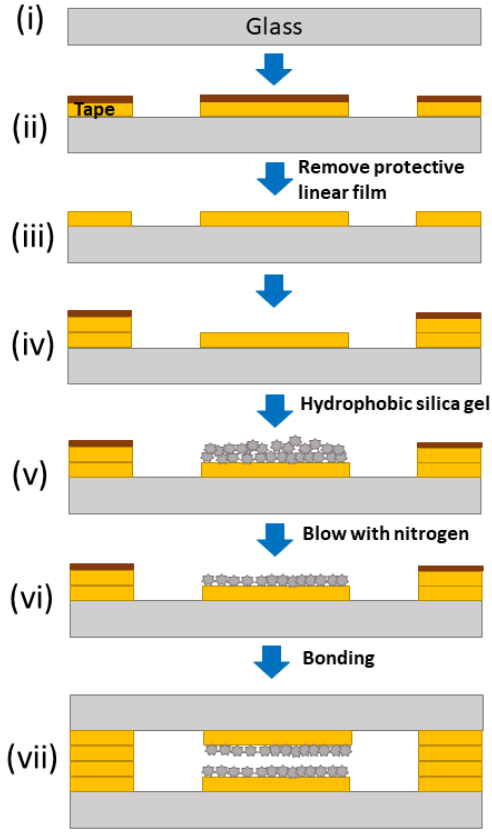
Figure 2. Schematic representation of the microchip fabrication: (i) bare glass substrate, ( ii ) fix adhesive tape with channel design, ( iii ) remove protective liner from adhesive tape, ( iv ) fix adhesive spacer, i.e. around edge of chip, ( v ) add hydrophobic silica gel to exposed adhesive tape, ( vi ) remove excess hydrophobic silica gel, ( vii ) close chip with identical upper plate. See main text for details.